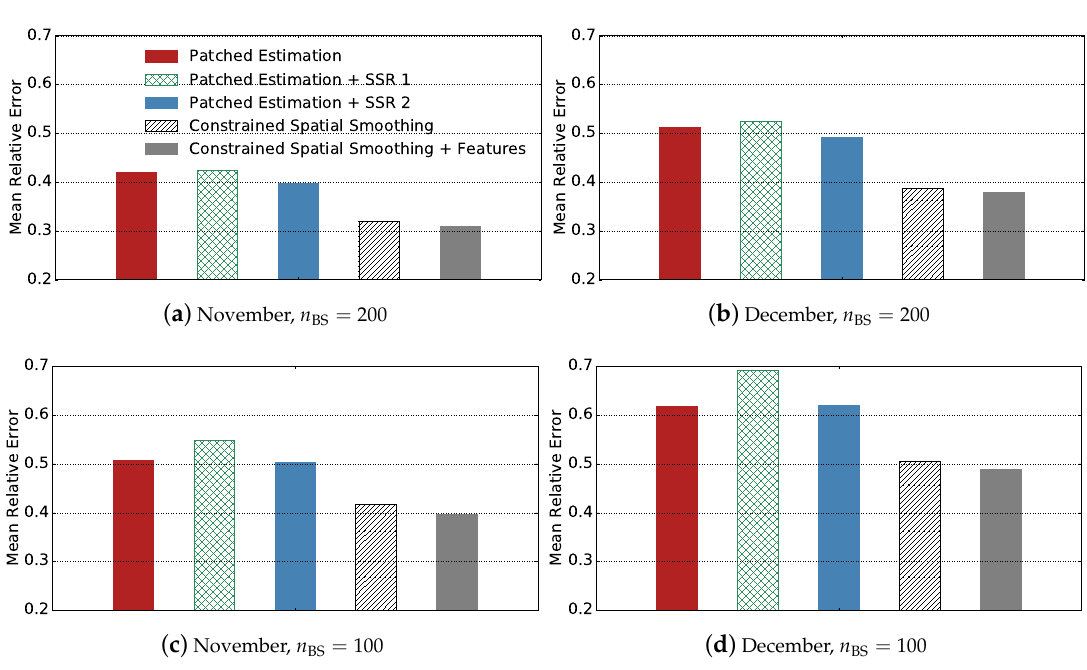
Figure 4. Comparison of the CDFs of estimation relative errors given by different methods when n BS = 100 for stress-testing. The legends follow the same order as the curves at relative error = 0.5. ( a ) compares the CDFs based on the data aggregated in November; ( b ) compares the CDFs based on the data aggregated in December.